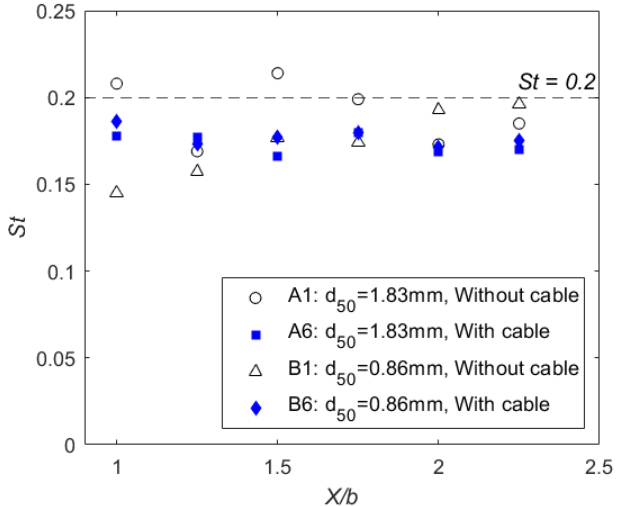
Figure 10. Peak vortex shedding frequencies f for points in the wake, located at one cylinder diameter, 40 mm, above the initial bed with increasing downstream distance ( X/b ) of the protected (A1 and B1) and unprotected piers (A6 and B6) for both d 50 = 0.86 mm (B) and 1.83 mm (A) sediment sizes.